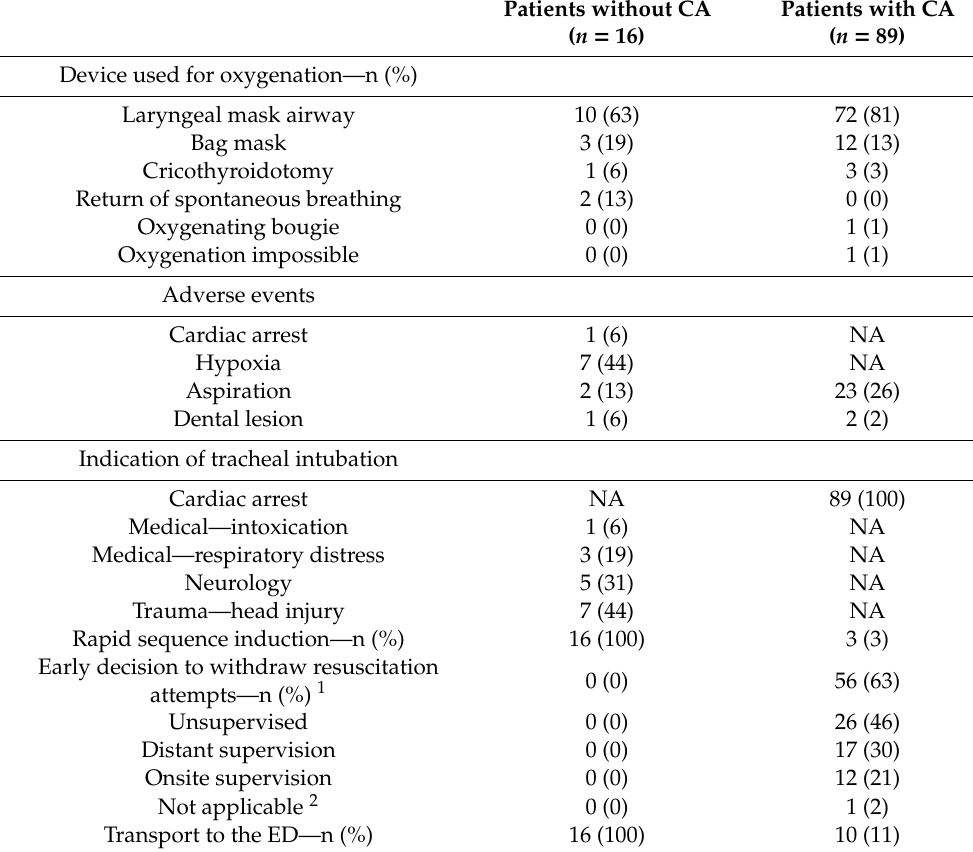
Patients without CA Patients with CA ( n = 16) ( n =